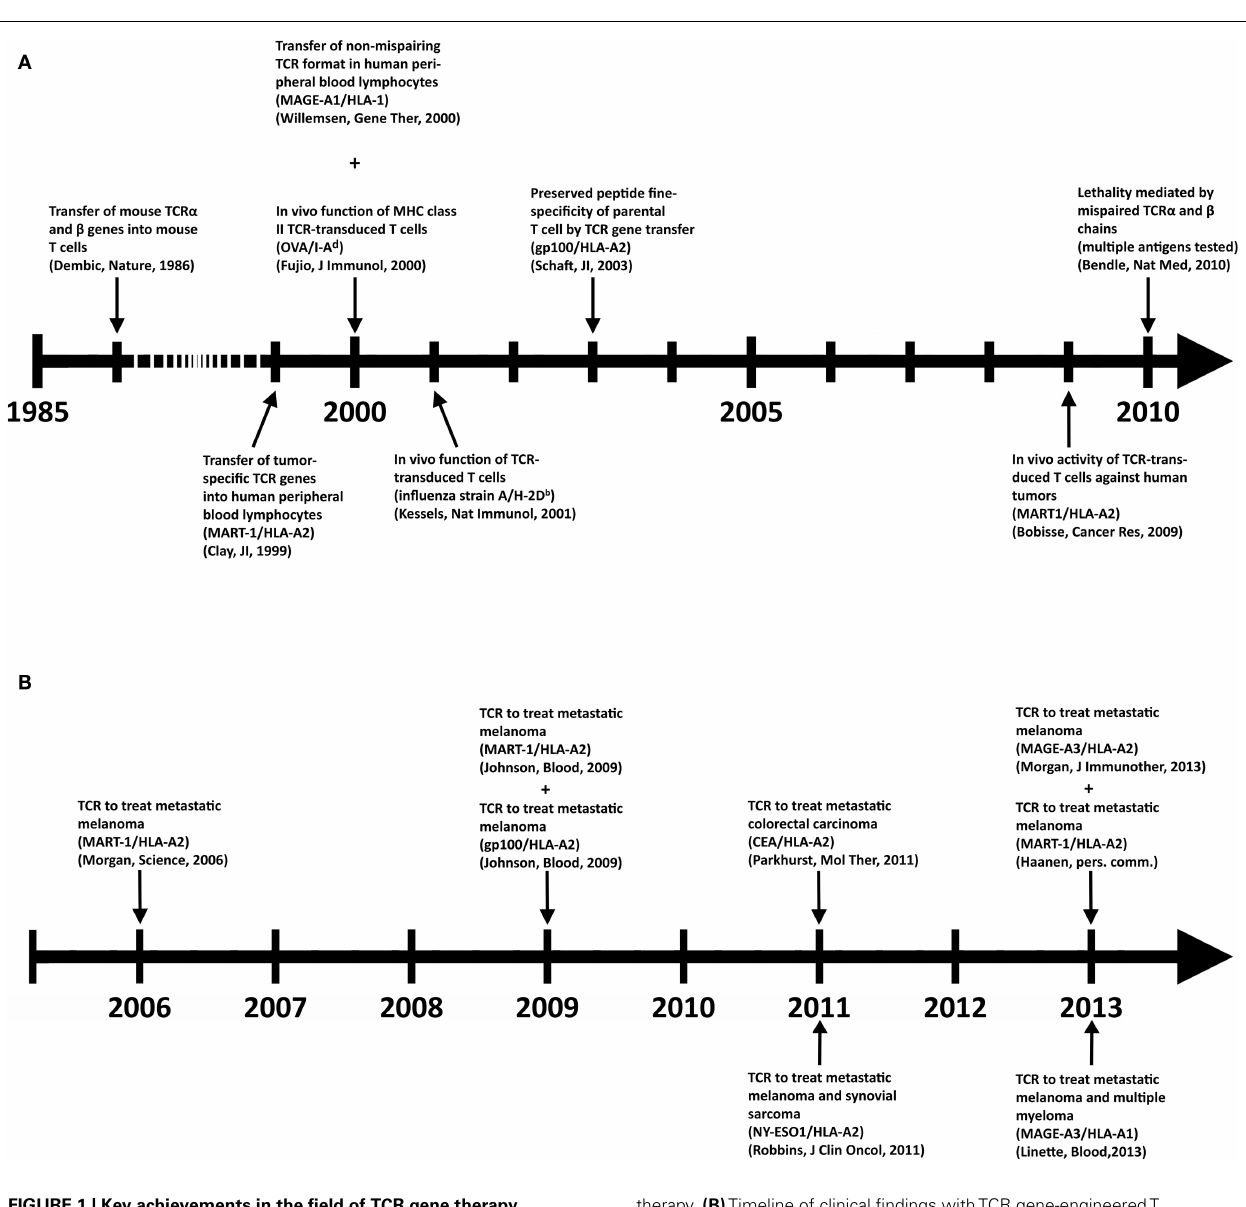
FIGURE 1 | Key achievements in the field of TCR gene therapy directed against solid tumors . (A) Timeline of selected preclinical findings that have contributed to the development ofTCR gene